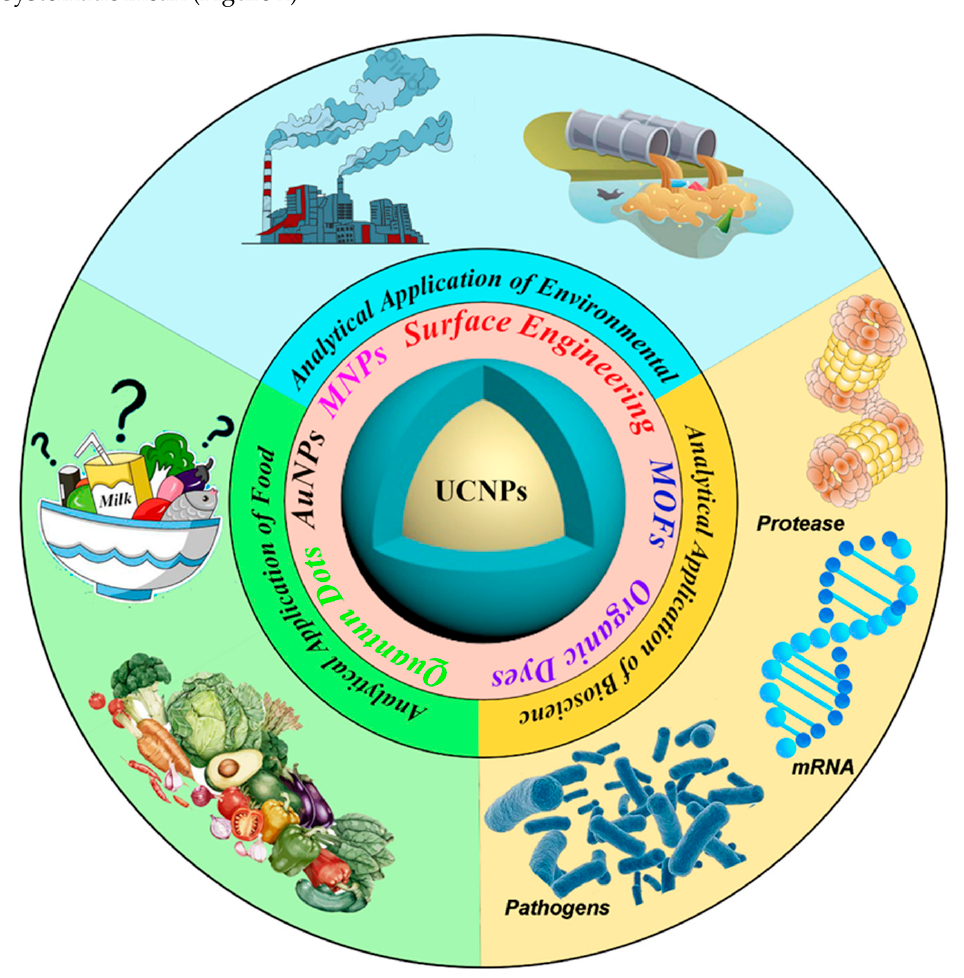
Figure 2. Schematic illustration of the fluorescent characteristics and sensing application of the UCNPs.